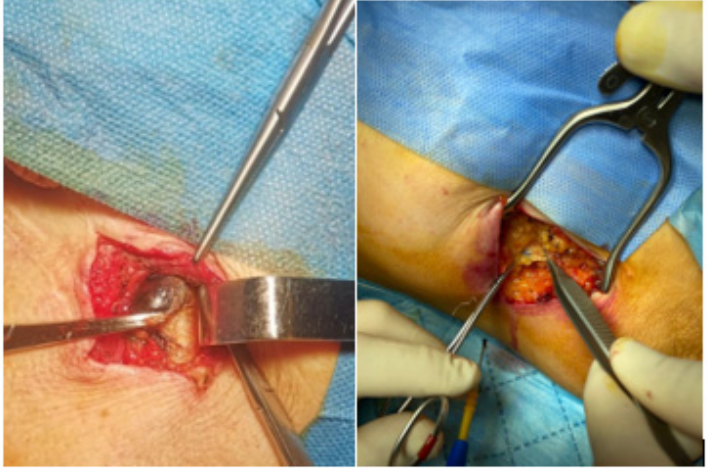
Figure 1. Sentinel lymph node—surgical specimen—Dr. Leventer Centre Collection. According to the ASCO-SSO (American Society of Clinical Oncology—Society of Surgical Oncology) guideline for SLNB in melanoma, and ESMO (European Society